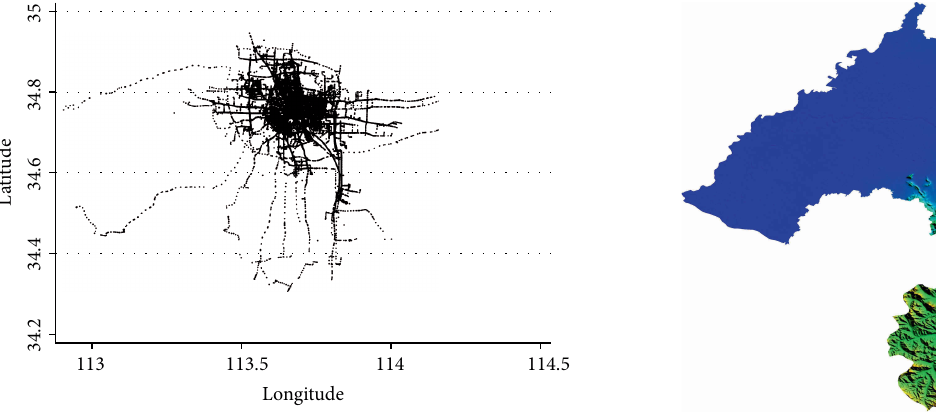
Figure 12: Taxi positions of Zhengzhou.